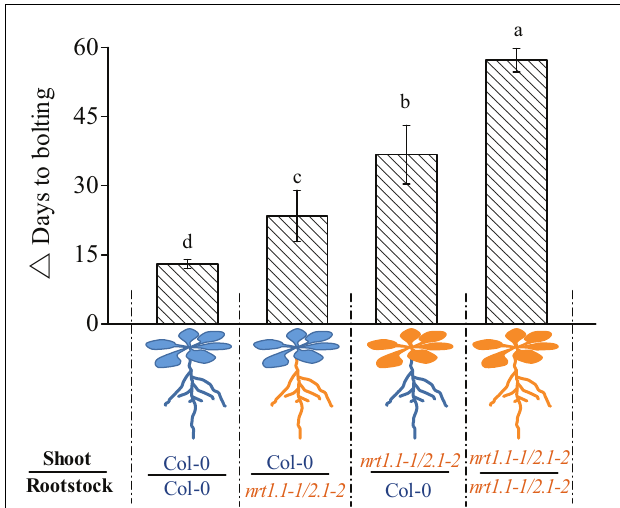
FIGURE 6 | Time of LD-induced flowering in grafted plants under 1 mM nitrate conditions. (cid:77) Days to bolting was determined by subtracting the bolting time of the plants grown under LD conditions from that of the plants grown under SD conditions. Raw data from the individual photoperiods are shown in Supplementary Figure 11 . Treatments are similar to those presented in Figure 3 . Bars represent means ± standard deviations ( n = 6). Different letters above the bars indicate significant differences between the means, as determined using a one-way ANOVA followed by Tukey’s multiple comparisons test ( P <